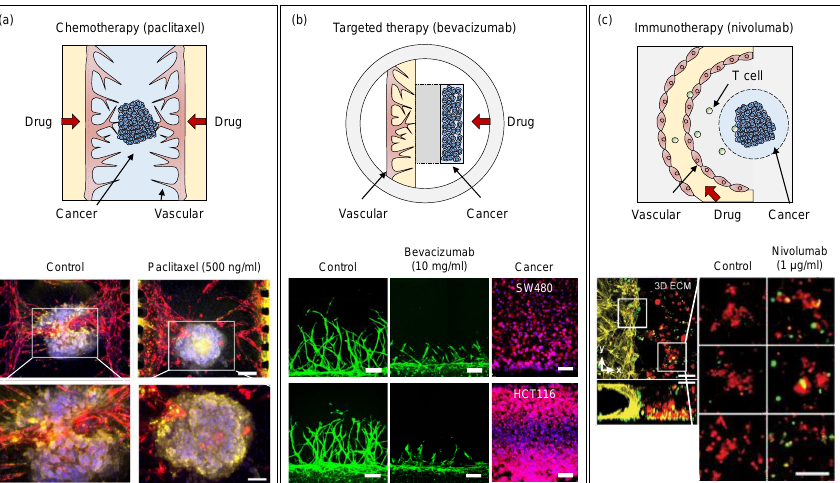
Figure 6. Examples of cancer-vascular models with anticancer drug screening. ( a ) On-chip tumor spheroid and blood vessel co-cultured microenvironment with biochemical and biophysical factors. Figure reproduced from Nashimoto et al., 2020 [67]. ( b ) A standardized microfluidic platform for high-throughput anti-angiogenic drug screening. Figure reproduced from Kim et al., 2021 [17]. ( c ) OoC device mimicking glioblastoma tumor niche including immune cells, brain microvessels, tumor-associated macrophages, and glioblastoma. Figure reproduced from Cui et al., 2020